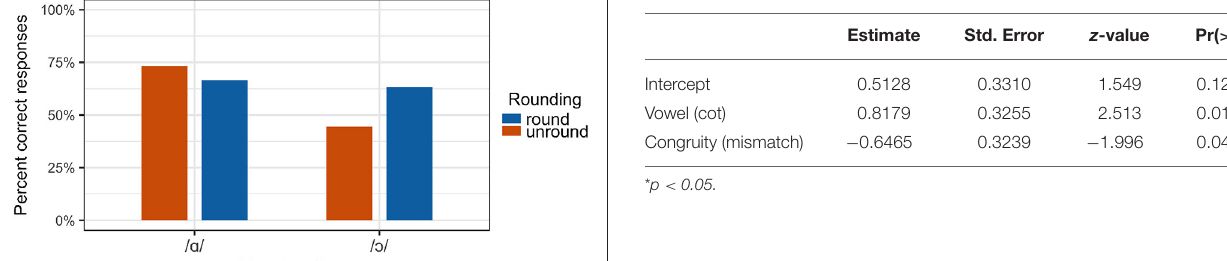
TABLE 2 | Mixed effects logistic regression model for responses in Experiment